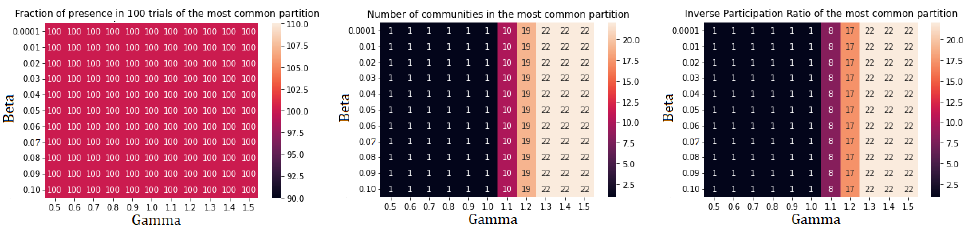
Figure A8. Performance indicators for Leiden algorithm applied to community III. There is no further subdivision.